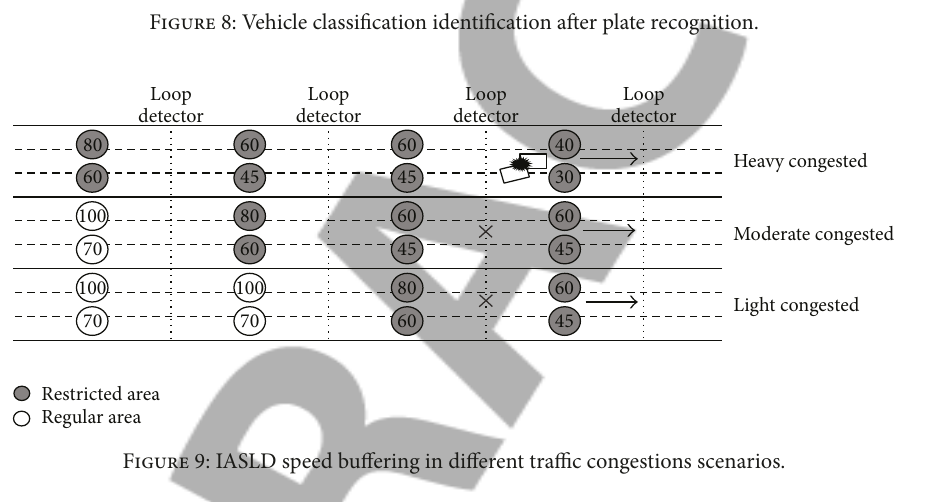
Figure 9: IASLD speed buffering in different traffic congestions